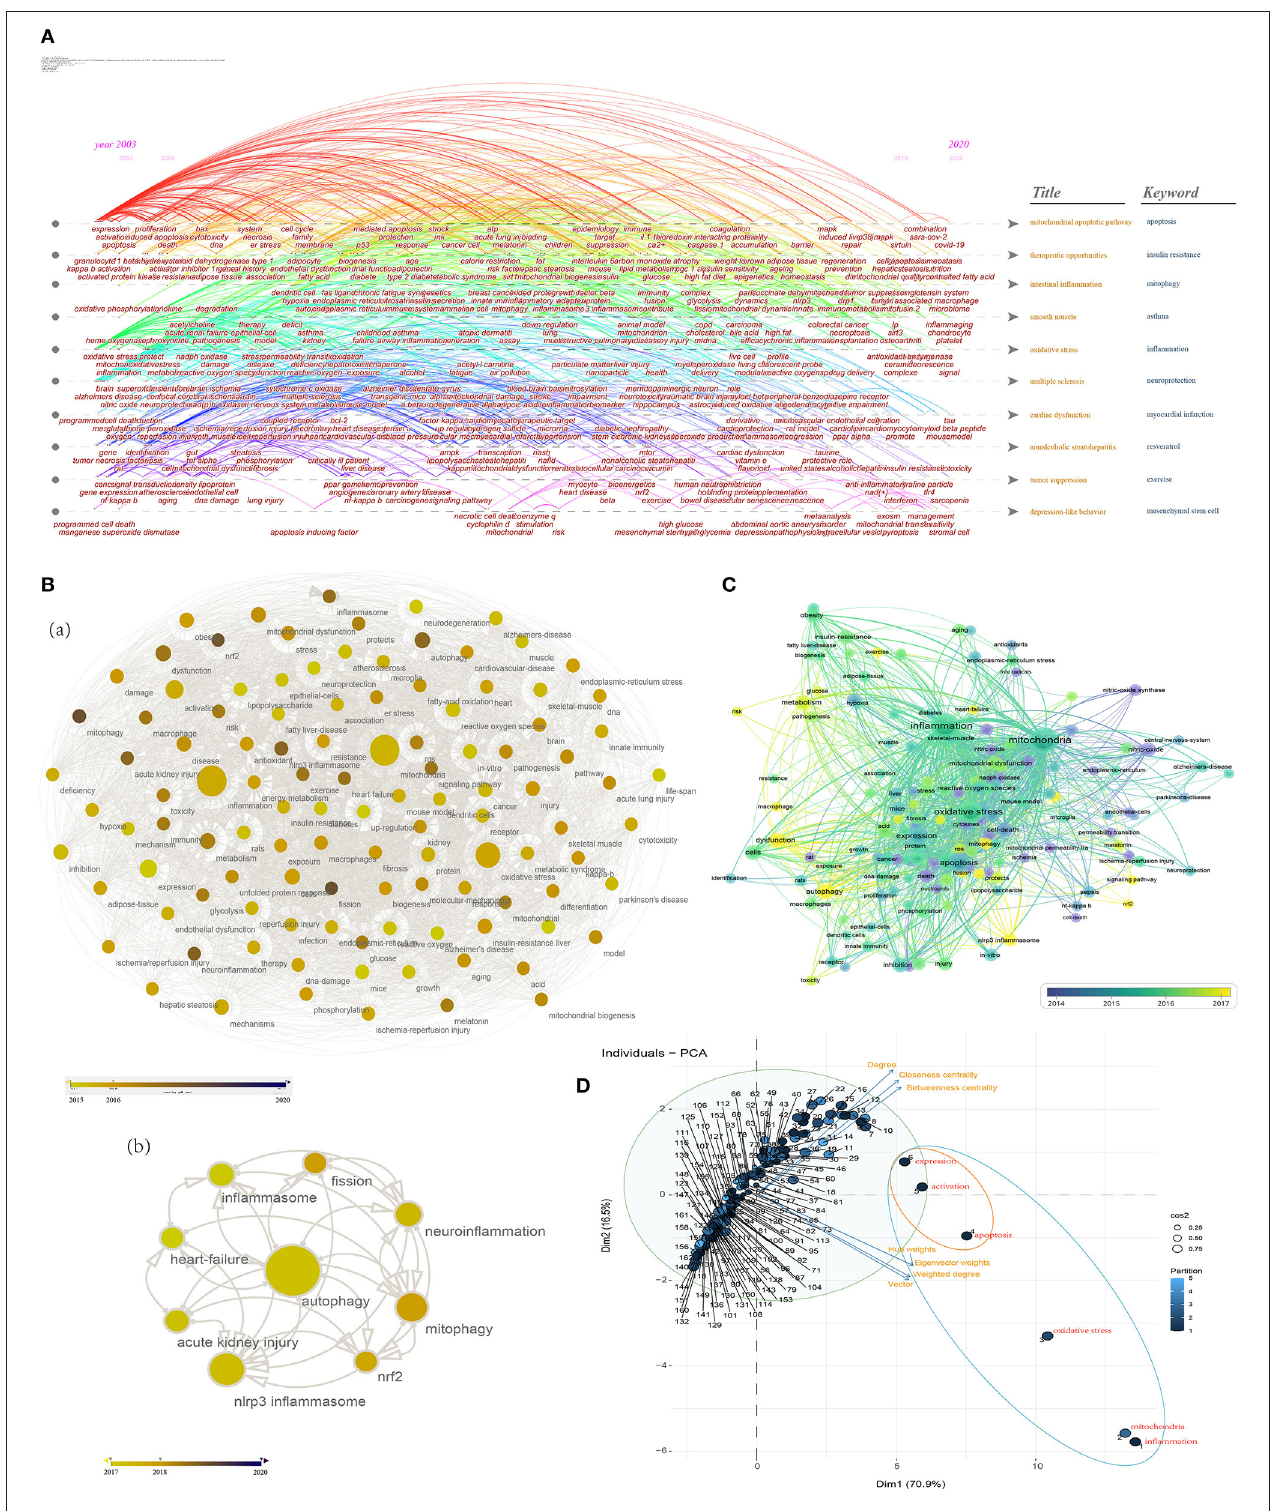
FIGURE 4 | Research hotspots and frontiers of “inflammation” AND “mitochondria” studies. (A) Time-based overlay (sub-network and cluster map) visualization based on “Title & Keywords” (two topics) through using CiteSpace; (B) Analyze and visualize the research hotspots in recent years [2015 to 2020 (a), 2017 to 2020 (b)] through Cytoscape software; (C) Co-occurrence analysis through VOSviewer (the minimum number of occurrences of a keyword was over five); (D) PCA results of the analysis of the top 162 identified keywords provide highlights for the research programs. Keywords (all keywords) = Author keywords + Keywords Plus. The blue circle represents high eigenvector centrality, and the orange circle represents both high closeness centrality and high eigenvector centrality.